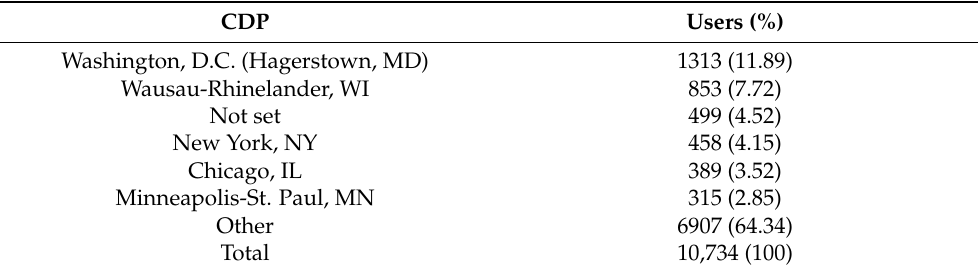
Table 2. AIN Usage by US Census Designated